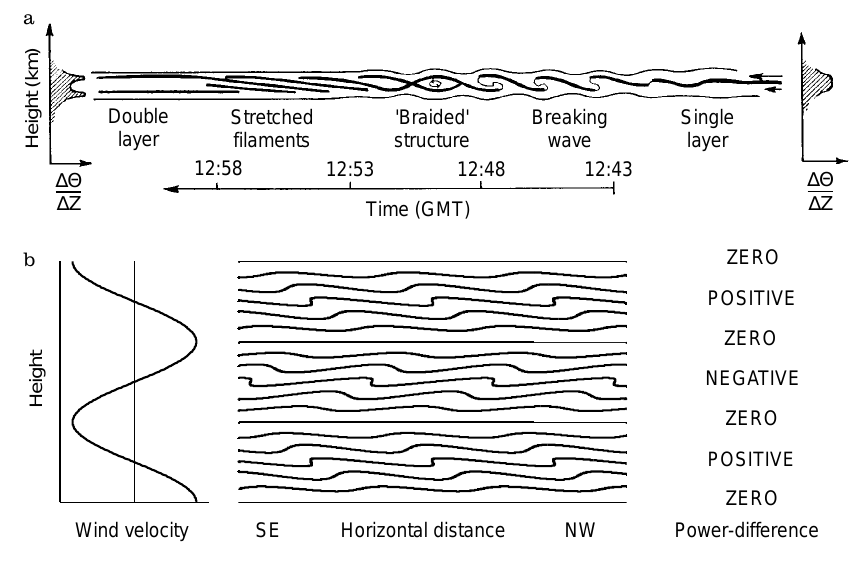
Fig. 7a, b. a Schematic representation of various stages in the development of Kelvin-Helmholtz instability, showing the formation of tilted structures, after Browning and Watkins (1970). b Model of tilted layers to explain the power- di(cid:128)erence e(cid:128)ects in Figs. 1, 2, 4, 5. Left panel: profile of the horizontal velocity of the long-period wave; Centre panel: cross section of the scattering layers, in the same vertical plane as the wave velocity plot. Right panel: variations of power di(cid:128)erence between (cid:135) (cid:104) and (cid:255) (cid:104) beams, as expected from the tilt angles of